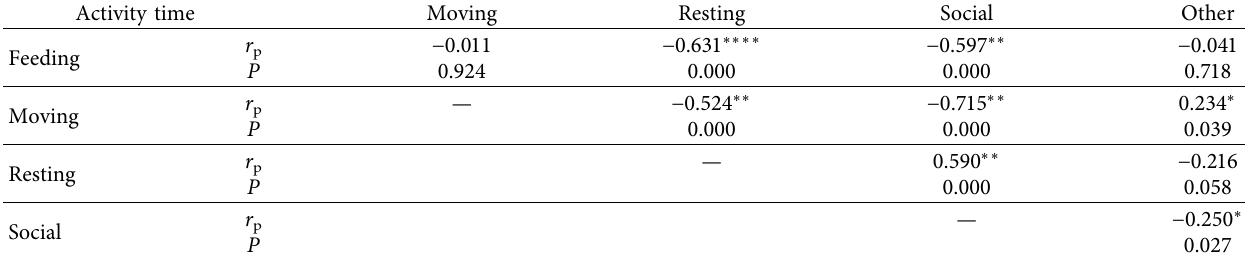
Table 2: Pearson correlation coefficients for different activity categories.